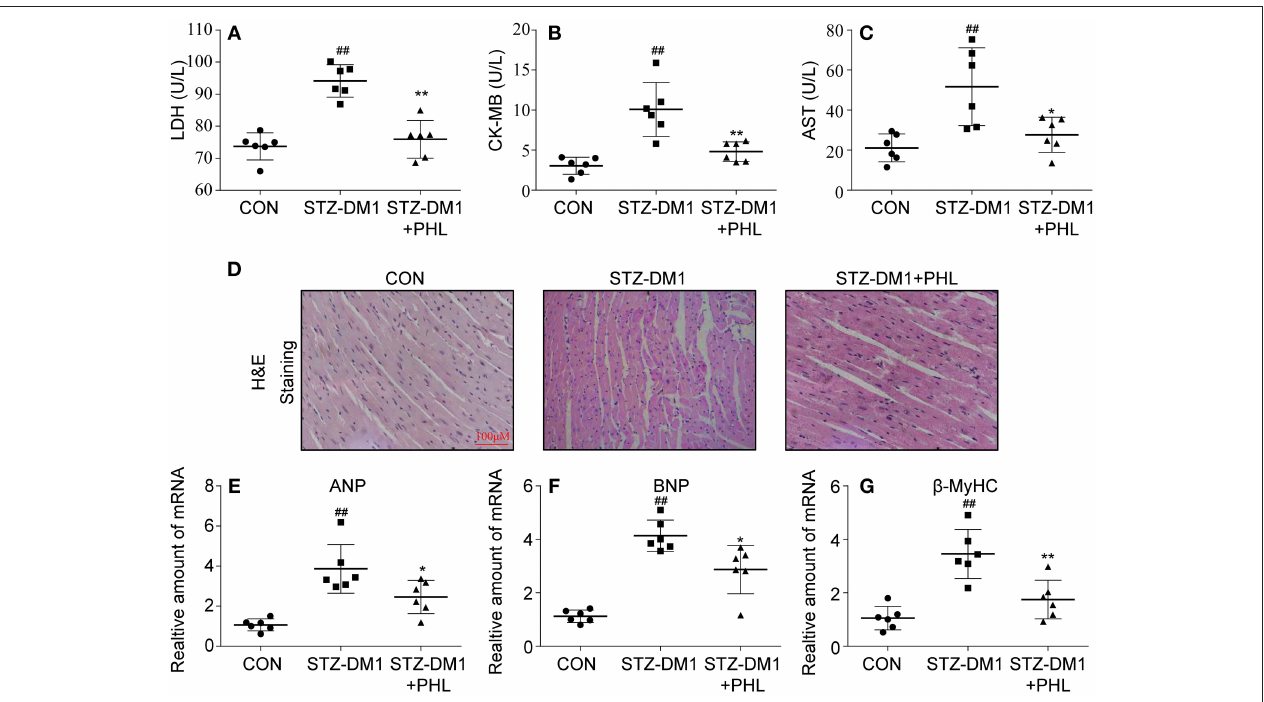
FIGURE 4 | PHL attenuated diabetes-induced cardiac injury. Diabetes mellitus was induced in male C57BL/6 mice by a single intraperitoneal (i.p.) injection of 100 mg/kg STZ and mice with fasting-blood glucose > 12mM were considered diabetes and then diabetic mice were orally treated with phloretin (PHL, 10 mg/kg), or vehicle by gavage once every 2 days for 8 weeks, which was administrated in diabetic mice. Serum levels of LDH (A) , CK-MB (B), and AST (C) were determined using indicated kits (Six mice in each group were used for above analysis). (D) Representative images from H&E sections of heart tissues are shown, × 400 amplification. (E–G) The mRNA expression levels of ANP (E) , BNP (F), and β -MyHC (G) in myocardial tissues of each group were determined by real-time qPCR. Six mice in each group were used for above analysis. * P < 0.05, ** P < 0.01 vs. STZ-DM1 group; ## P < 0.01 vs. CON